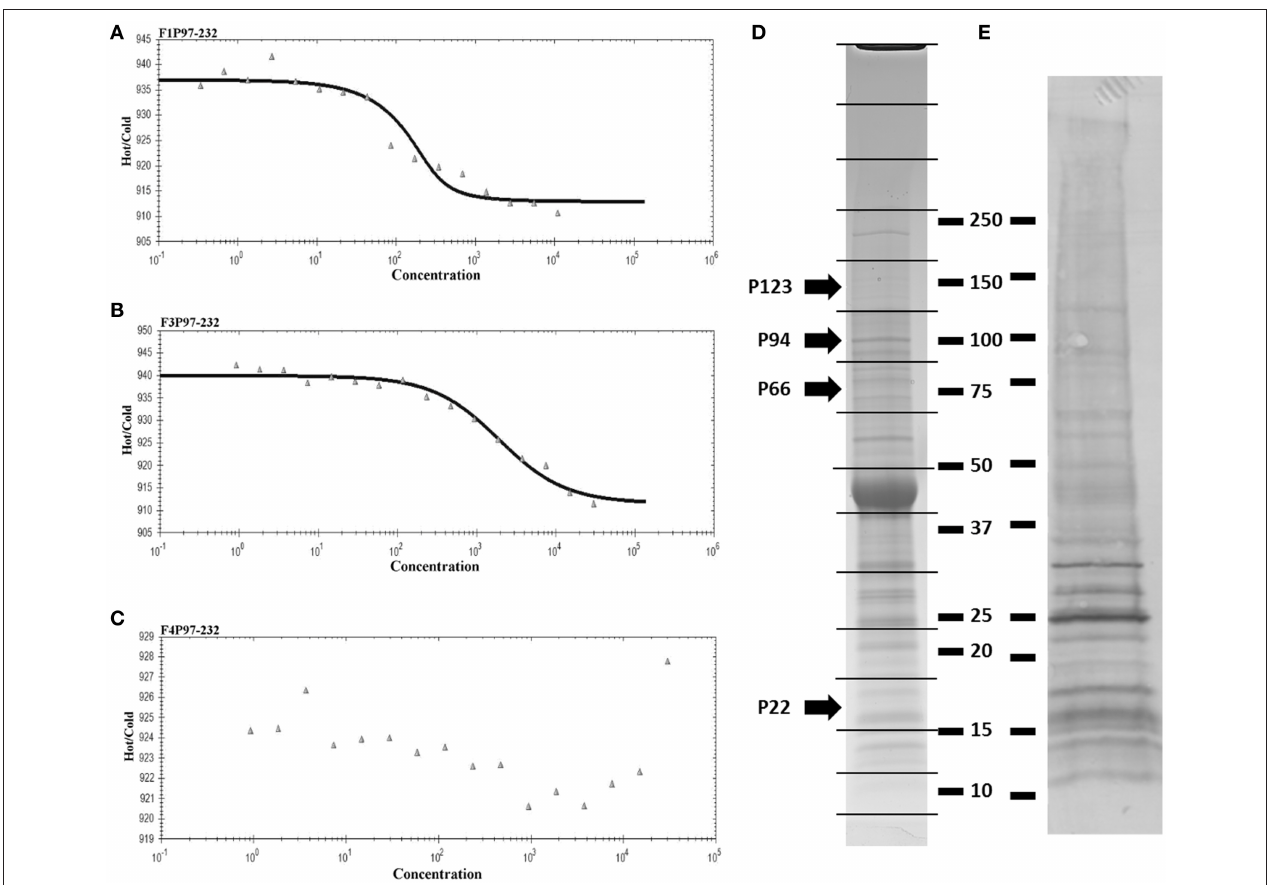
FIGURE 5 | Actin-binding to M. hyopneumoniae proteins. Thermophoretic output representing interactions between F1 P97 – 232 (A) , F3 P97 – 232 (B) , and F4 P97 – 232 (C) and actin. Concentration of the non-fluorescence molecule is plotted against the thermophoretic movement of the fluorescent molecule (actin). F1 P97 – 232 and F3 P97 – 232 bound actin with a K D ’s of 34.2nM and 1.79 µ M, respectively. A K D could not be assigned to F4 P97 – 232 . (D) SDS-PAGE profile of M. hyopneumoniae proteins that eluted with trifluoroacetic acid from an avidin column containing biotinylated actin as bait. 143 proteins were identified when each of the 16 slices were digested with trypsin (in gel) and analyzed by LC-MS/MS. P123 J (P97 preprotein homolog from strain J) and cleavage fragments of P123 J that were identified by LC-MS/MS are indicated by arrows. Molecular weight markers (kDa) are shown on the right. (E) Ligand blot depicting M. hyopneumoniae whole cell lysate separated by SDS-PAGE and probed with biotinylated (monomeric) G-actin.